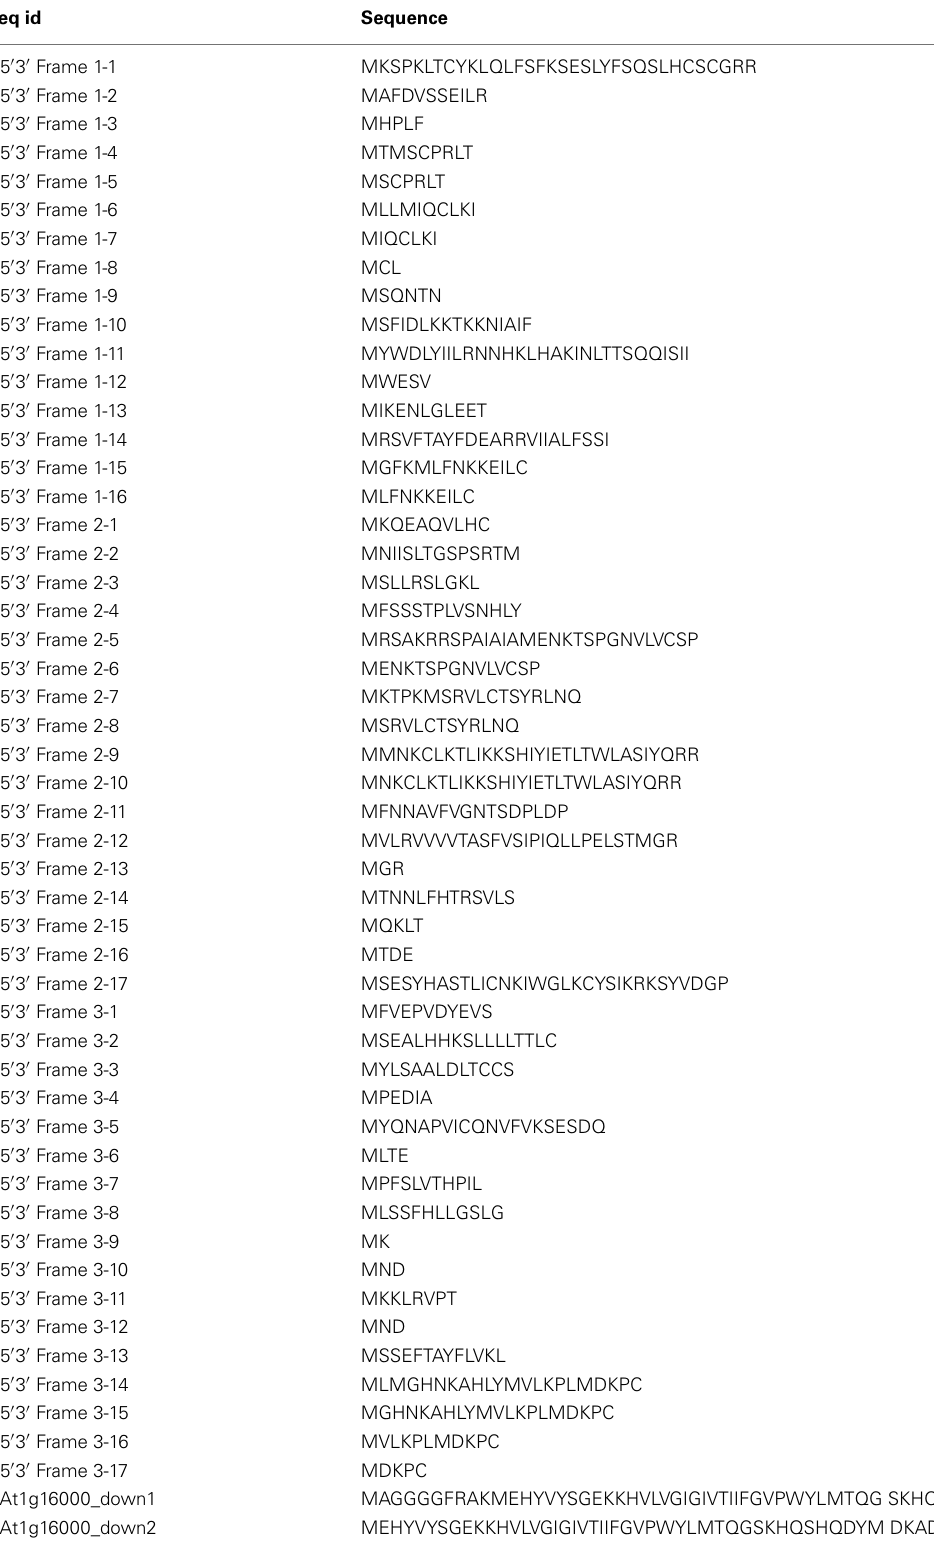
TableA3 | Sequences of upstream and downstream regions ofAt1g1600. Seq